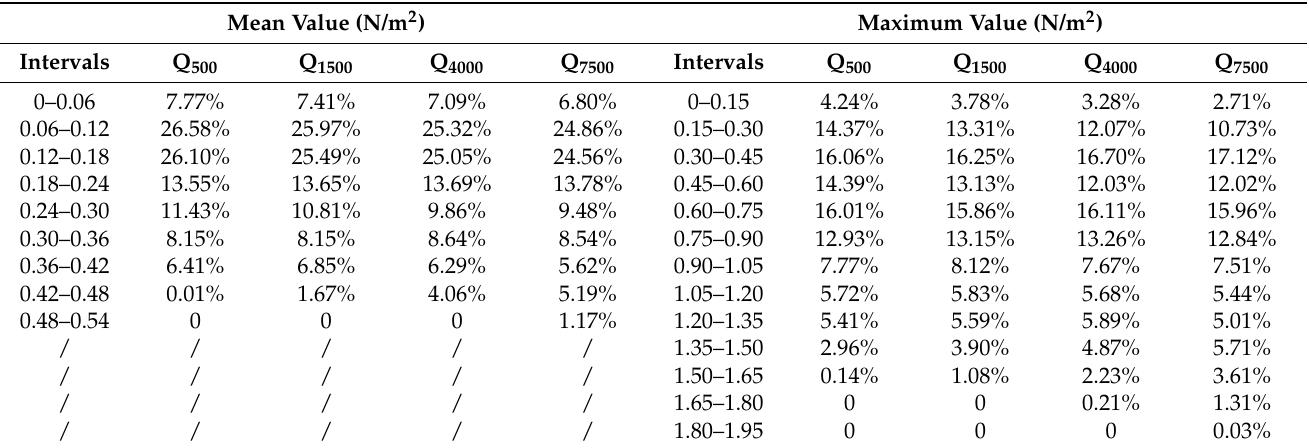
Table 2. The proportion condition of mean and maximum bed shear stress in the YRD of four